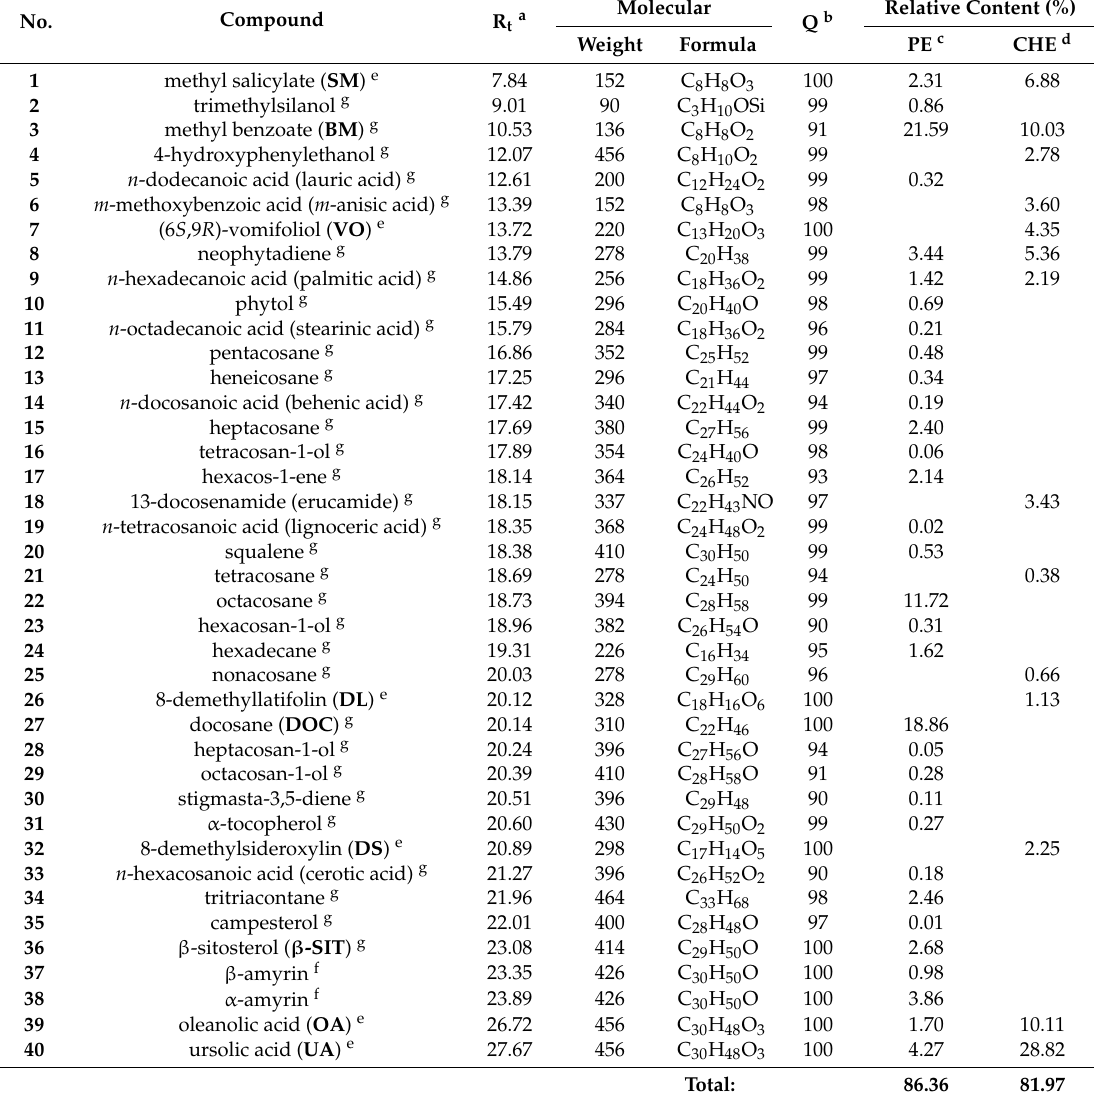
Table 1. GC-MS data of identified constituents in the G. procumbens dry lipophilic leaf extracts.